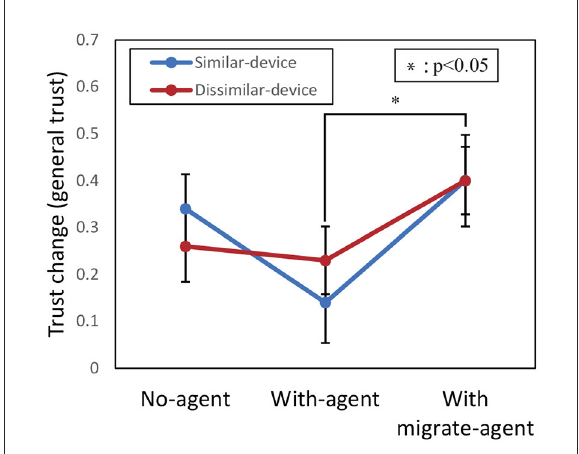
FIGURE5 Results of comparison between mean scores of trust change of general trust. Error bars represent standard errors.